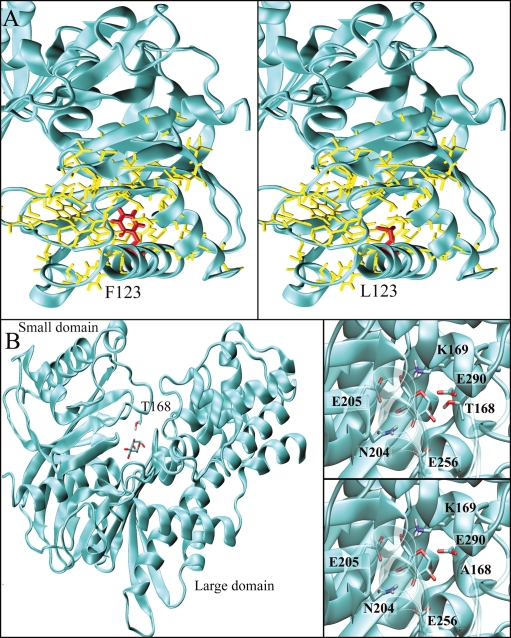
Structural features of mutations p.Phe123Leu and p.Asp168Ala GCK.The structure of GCK in the closed form (PDB code: 1v4s) is represented by cyan ribbons. A) Mutation p.Phe123Leu. Phe123 is structured inside the hydrophobic core of the small domain. Yellow sticks represent hydrophobic residues that constitute the core. Phe123 and Leu123 are represented by red sticks (left and right panel, respectively). B) The sticks represent residue Thr168 and glucose. The right panels show a close-up view of the glucose-binding cleft for the wild-type (top) and for the Ala168 mutant (bottom).